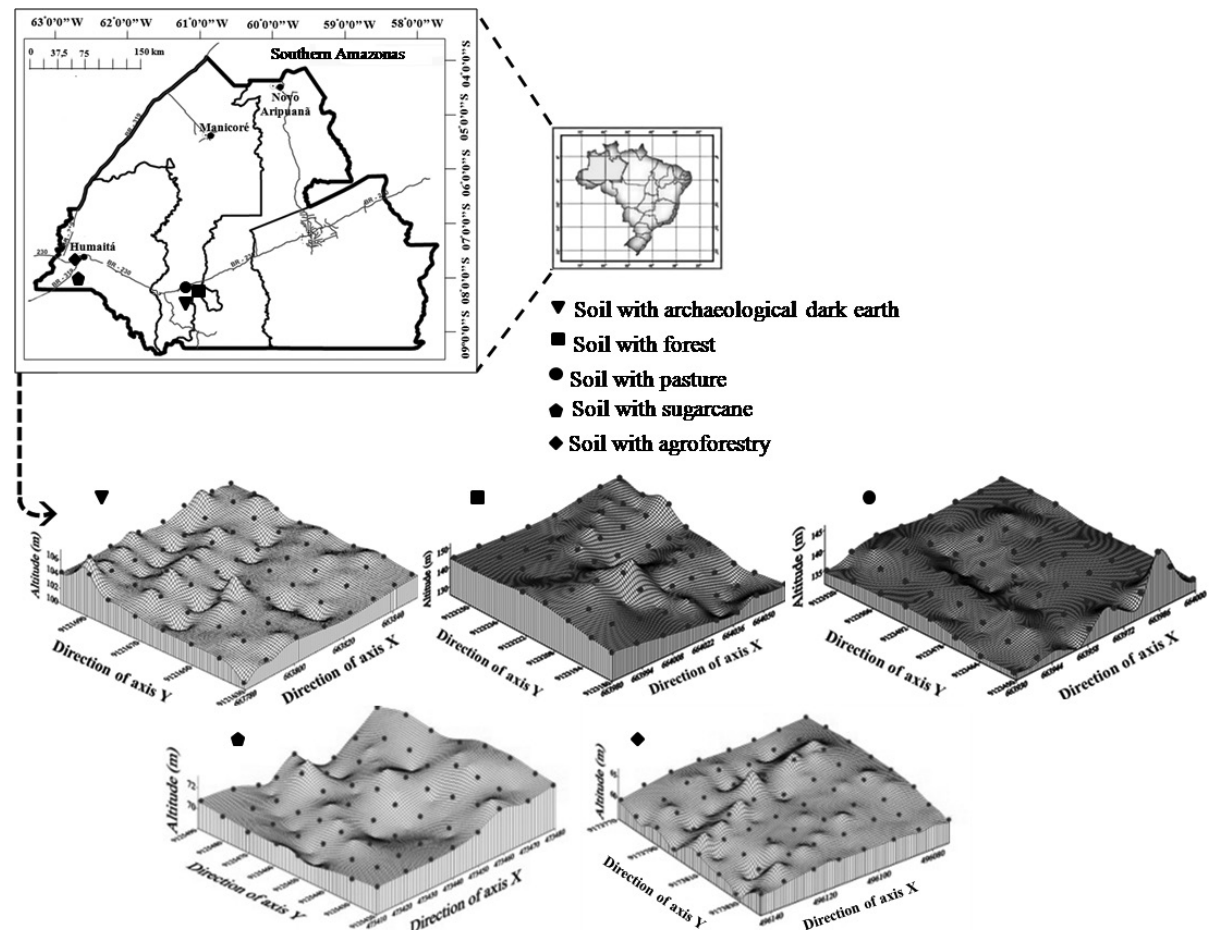
Figure 1. Area location and Digital Elevation Model (DEM) of the environments in southern